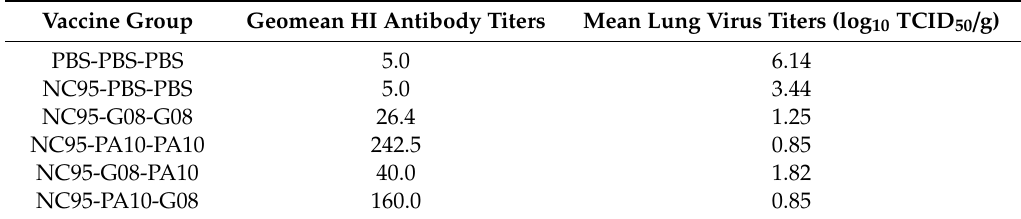
Table 5. Correlation between HI antibody titers against the challenge virus (MO15) and virus titers in the lungs.